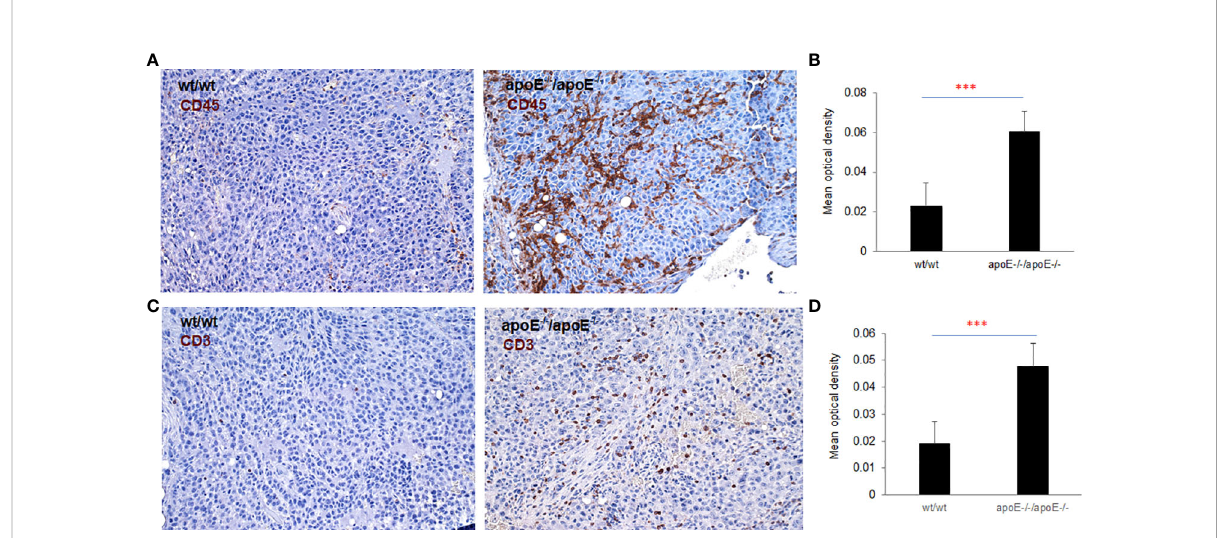
FIGURE 9 To validate nanostring results, both CD45 and CD3 expression were examined with IHC staining in the tumors from WT or apoE-/- mice following injection with WT or apoE-/- tumor cells. Representative images of CD45 (A) and CD3 (C) staining visualized with DAB (brown) and counterstained with hematoxylin (blue, nuclei). (B, D) Optical density (mean gray value) obtained by color deconvolution analysis. Optical density graph bars represent the mean ± SD (n = 30 images). ***p<0.001, determined by unpaired two-tailed Student ’ s t-test. Wt/wt: wt B16 cells injected in wt mice; apoE-/- /apoE-/-: apoE-/- cells injected in apoE-/- mice.